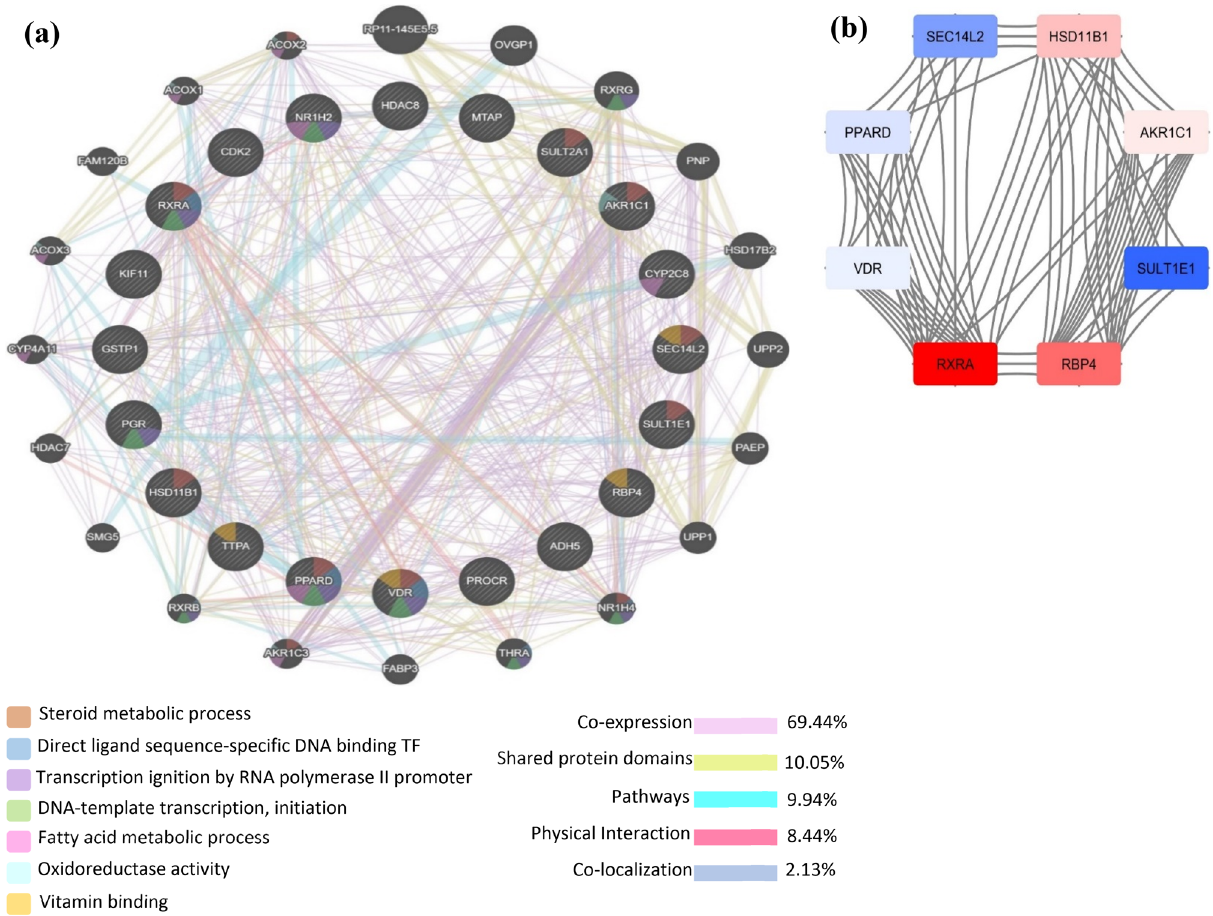
Figure 2. ( a ) Network of co-expression of 20 common targets of XNT constructed with GeneMANIA. The gene are linked to each other by the functional associated networks. Black nodes: gene targets, color nodes represent top expressed genes and their molecular functions filtered on their FDR score, colored lines: represent different interactions. ( b ) The 8 highly co-expressed targets from the GeneMANIA network identified via cytoscape.